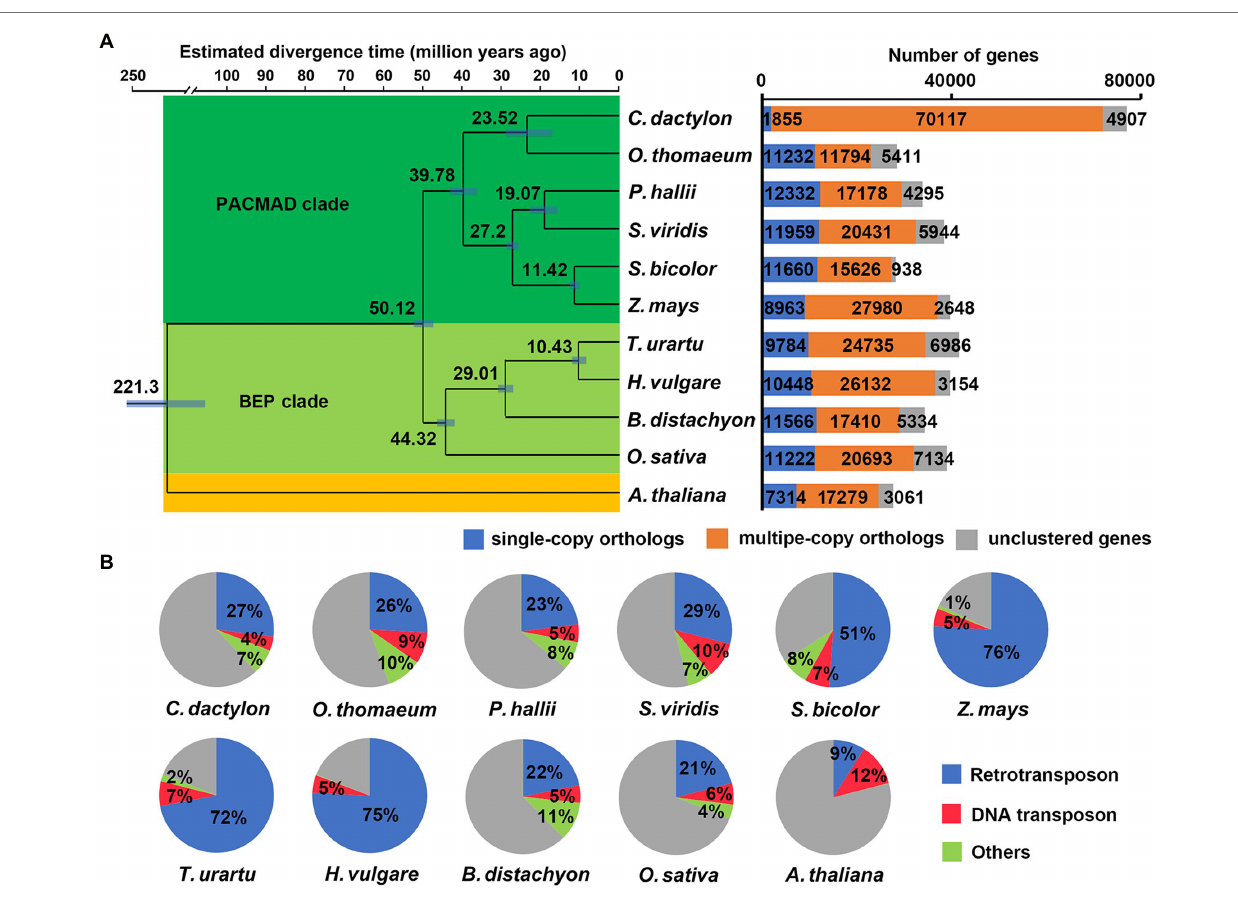
FIGURE 2 | Comparative genomic analysis among C. dactylon and other plant species. (A) Phylogenetic relationship, divergence time, and gene family clustering of C. dactylon and other ten plant species. Left panel, Maximum parsimony (MP) species tree was constructed using protein sequences of 112 shared single-copy orthologous genes. The numbers in the brackets indicate the estimated divergence time of each node, and the blue bars show the 95% confidence interval of divergence time. All the nodes are 100% bootstrap support. Right panel, Orthologous gene families of C. dactylon and other ten plant species. (B) Comparison of repetitive sequences in C. dactylon and other ten plant